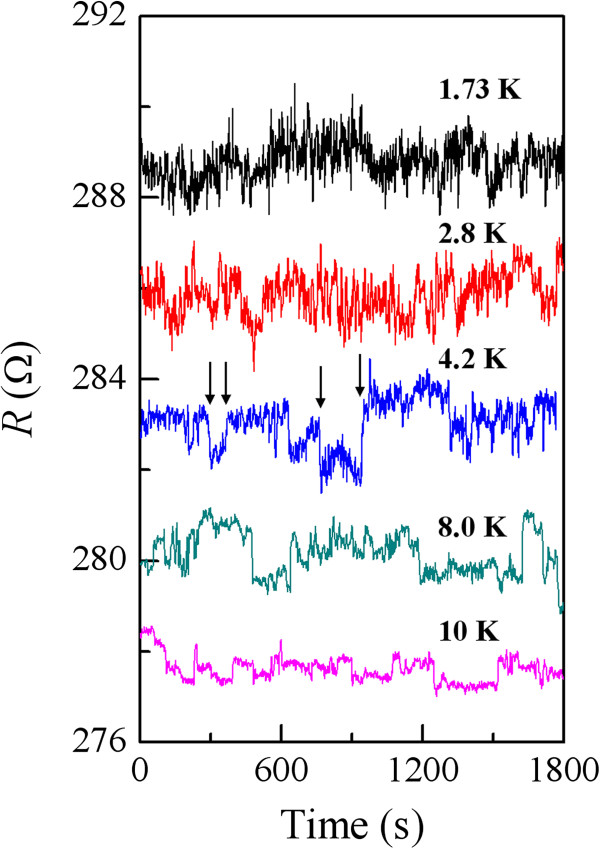
Variation of resistance with time for the NW1 device. Resistance as a function of time for the NW1 device at five temperatures, as indicated. The resistances at 8.0, 4.2, 2.8, and 1.73 K have been offset by 2, 4, 6, and 8 Ω, respectively, for clarity. The arrows indicate four slow fluctuations occurring at ≈ 280, ≈ 370, ≈ 760, and ≈ 945 s in the resistance curve for T = 4.2 K.